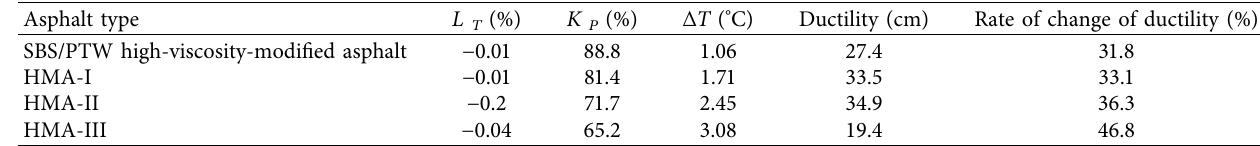
Table 10: Physical properties after aging.